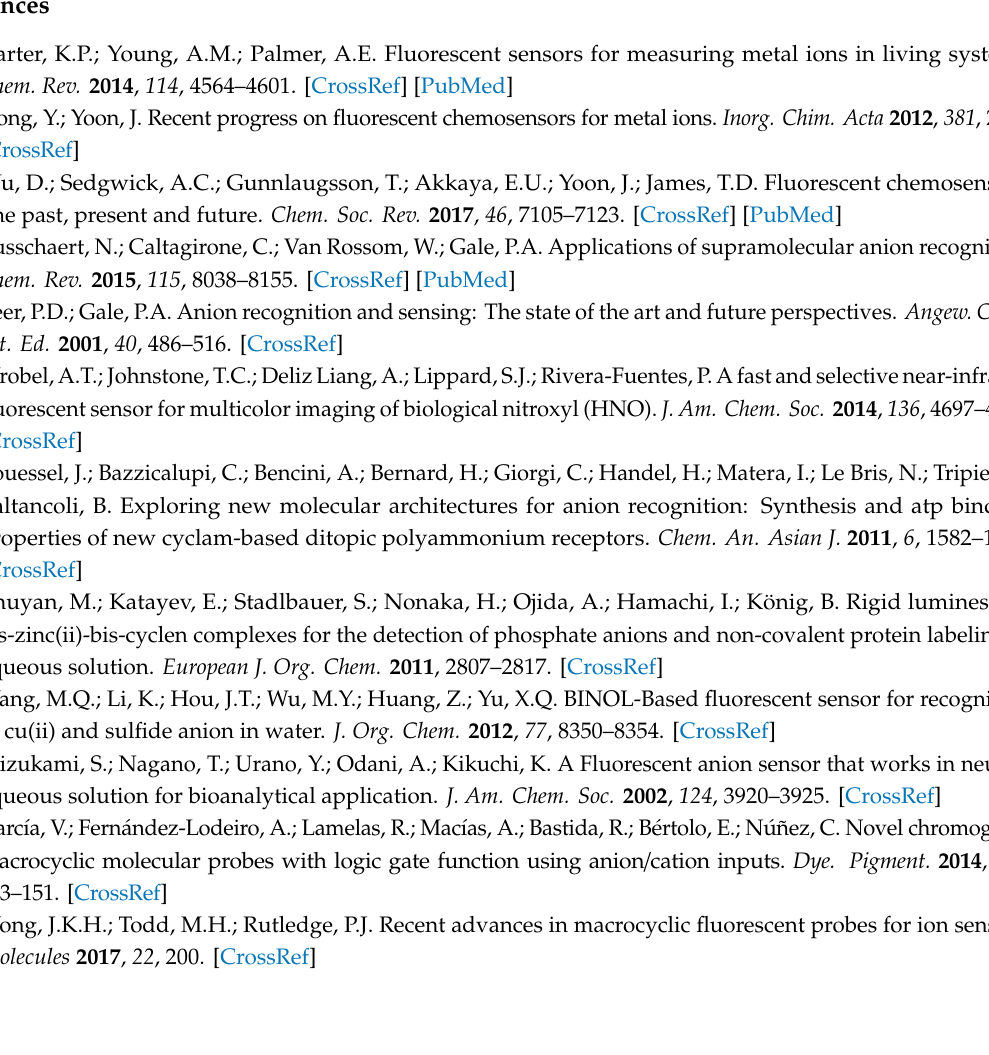
cations; Figure S2. Emission spectra of 4 in the absence and presence of 5 equivalents of metal cation. Conditions: 4 = 5.0 µ M; pH 7.0 ± 0.2 bu ff ered with 10 mM HEPES; T = 298 K; λ exc = 458 nm; Figure S3: Proposed binding mode for Cu 2 + to chemosensor 4; Figure S4: Normalized emission changes in 4 upon addition of Cu 2 + (black dots) and respective exponential fitting for a 2:1 binding model (red line). Conditions: 4 = 5.0 µ M; pH 7.0 ± 0.2 bu ff ered with 10 mM HEPES; T = 298 K; λ exc = 458 nm; Figure S5: 1 H NMR spectra of 4 (blue), with subsequent addition of two equivalents of Cu 2 + (green) and two equivalents of EDTA (red). Spectra were acquired in a 1:1 mixture of CD 3 OD and D 2 O; Figure S6: Normalized intensity from a solution containing 4 (5 µ M) and Cu 2 + (25 µ M) upon increasing concentrations of GTP. Conditions: 4 = 5.0 µ M; pH 7.0 ± 0.2 bu ff ered with 10 mM HEPES; T = 298 K; λ exc = 458